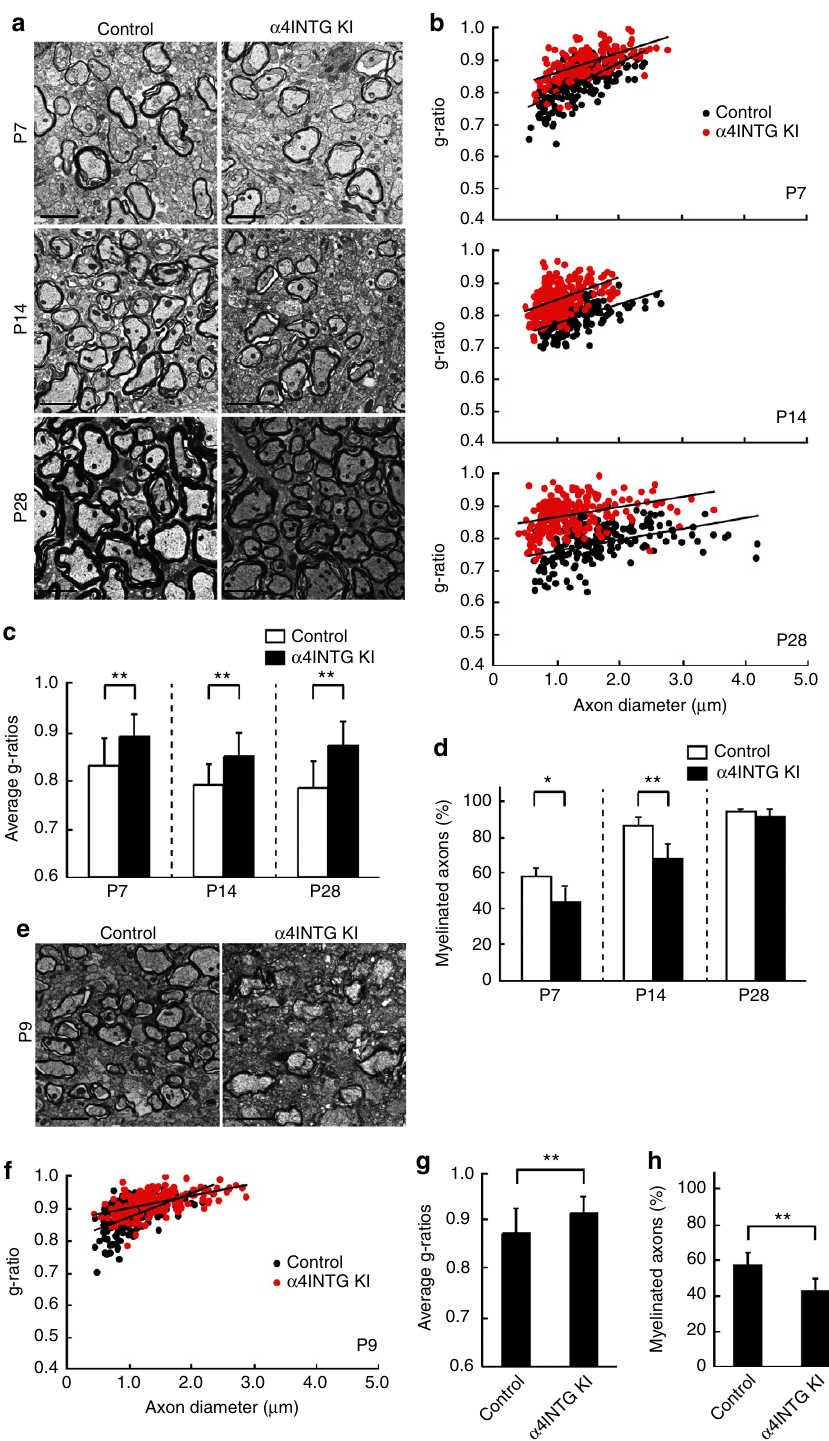
Figure 6 | Mutant mice of a 4 integrin exhibit decreased myelin thickness during postnatal development. ( a – d ) Electron microscopic data of 7-, 14- or 28-day-old spinal cords are shown. Data are representative. Scale bar, 2 m m. The g-ratios (200–300 myelinated fibres) are plotted for axon diameters. Average g-ratios are also shown. Data were evaluated using Student’s t -test (** P ¼ 5.59E (cid:2) 25 (P7), 4.22E (cid:2) 31 (P14) or 3.54E (cid:2) 50 (P28): n ¼ 212–239 axons of two independent experiments). The percentage of myelinated axons is indicated. Data were evaluated using Student’s t -test (** P ¼ 0.000420 (P14), * P ¼ 0.0105 (P7) or non-significance (P28); n ¼ 6–8 areas of two independent experiments). ( e – h ) Electron microscopic data of 9-day-old corpus callosum are shown. Data are representative. Scale bar, 2 m m. The g-ratios (200–300 myelinated fibres) are plotted for axon diameters. Average g-ratios are also shown. Data were evaluated using Student’s t -test (** P ¼ 1.50E (cid:2) 16; n ¼ 196–202 axons of two independent experiments). The percentage of myelinated axons is indicated. Data were evaluated using Student’s t -test (** P ¼ 0.00305; n ¼ 7–8 areas of two independent